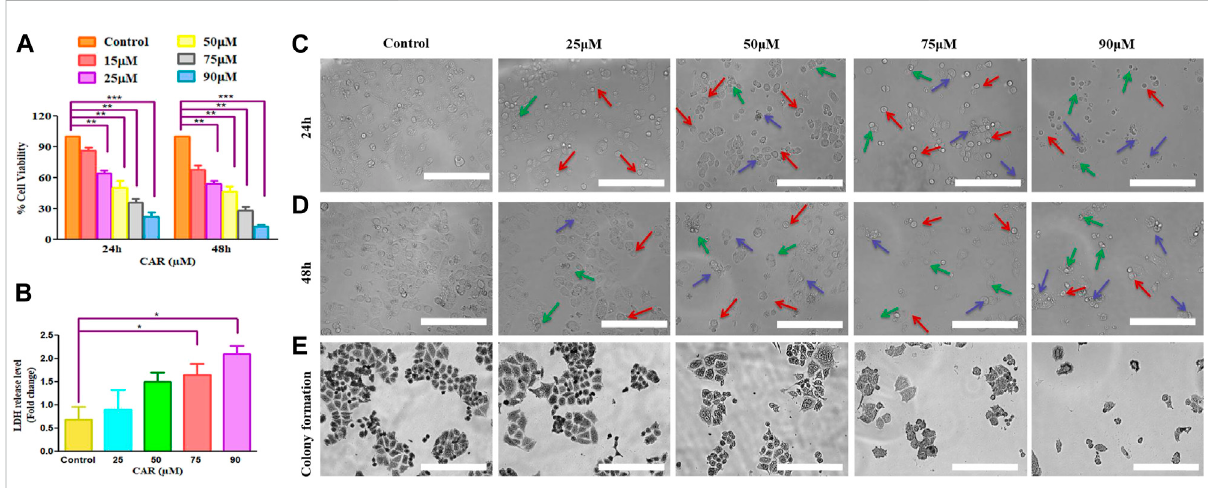
FIGURE 1 CAR effectively suppressed the growth and colony formation of cervical cancer cells. (A) Bar graph represents the percent (%) viability of C33A cells as compared to the vehicle-treated cells after treatment with CAR for 24 and 48 h (B) Bar graph represents the percent (%) LDH released asanalyzedbyLDHassayinCAR-treatedC33Acell. (C,D) Morphological alterations inC33A cellsaftertreatmentwithCAR(25 – 90 µM)for24and48 h as indicated by red, blue and green arrows representing swelling, shrinkage and disintegration of cell organelles. (E) CAR treatment reduced the number of colonies in a dose-dependent manner after treatment with various doses of CAR. Photomicrographs were captured at 20X magni fi cation (scale bar = 100 µm). Each value in the bar graph represents the mean ± SEM of three independent experiments. Signi fi cant difference among the treatment groups were analyzed by one-way ANOVA followed by Dunnett post-hoc test (* p < 0.05 , ** p < 0.01 , *** p < 0.001 represent signi fi cant difference compared with